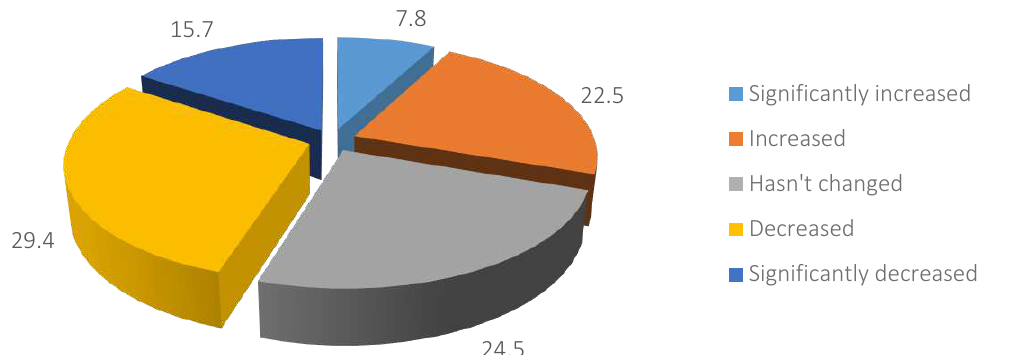
Figure 2. Changes in the SME sales volume of products/services since the start of the pandemic